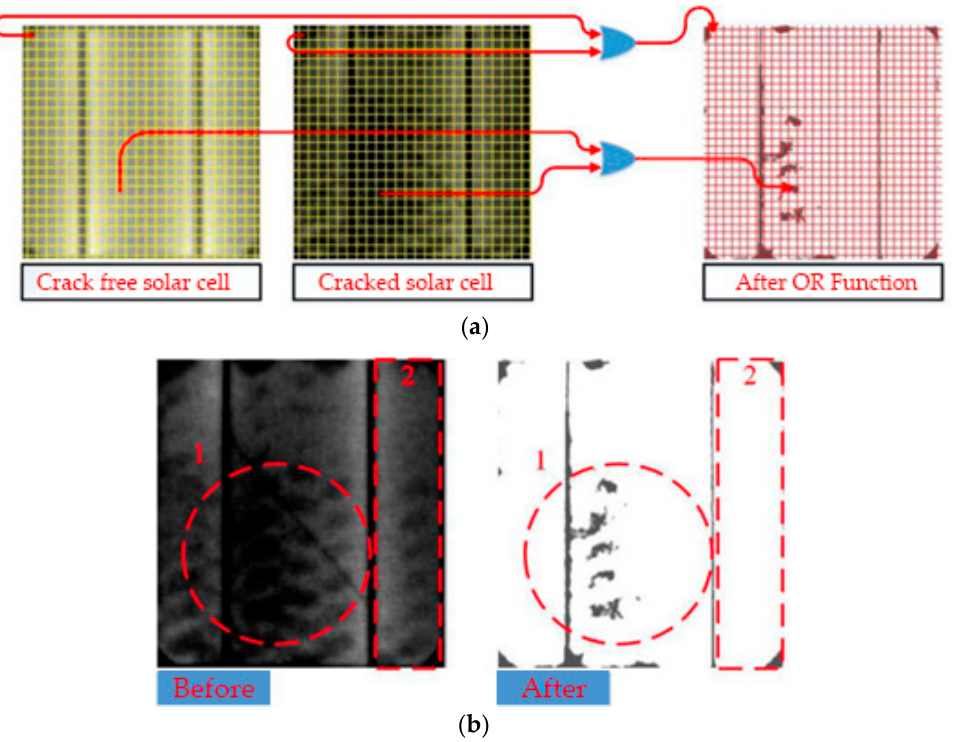
Figure 10. EL enhancement technique for solar cell crack detection: ( a ) process of achieving higher quality cracked solar cell images through a novel detection technique [35]; ( b ) before and after images using the detection technique [35].